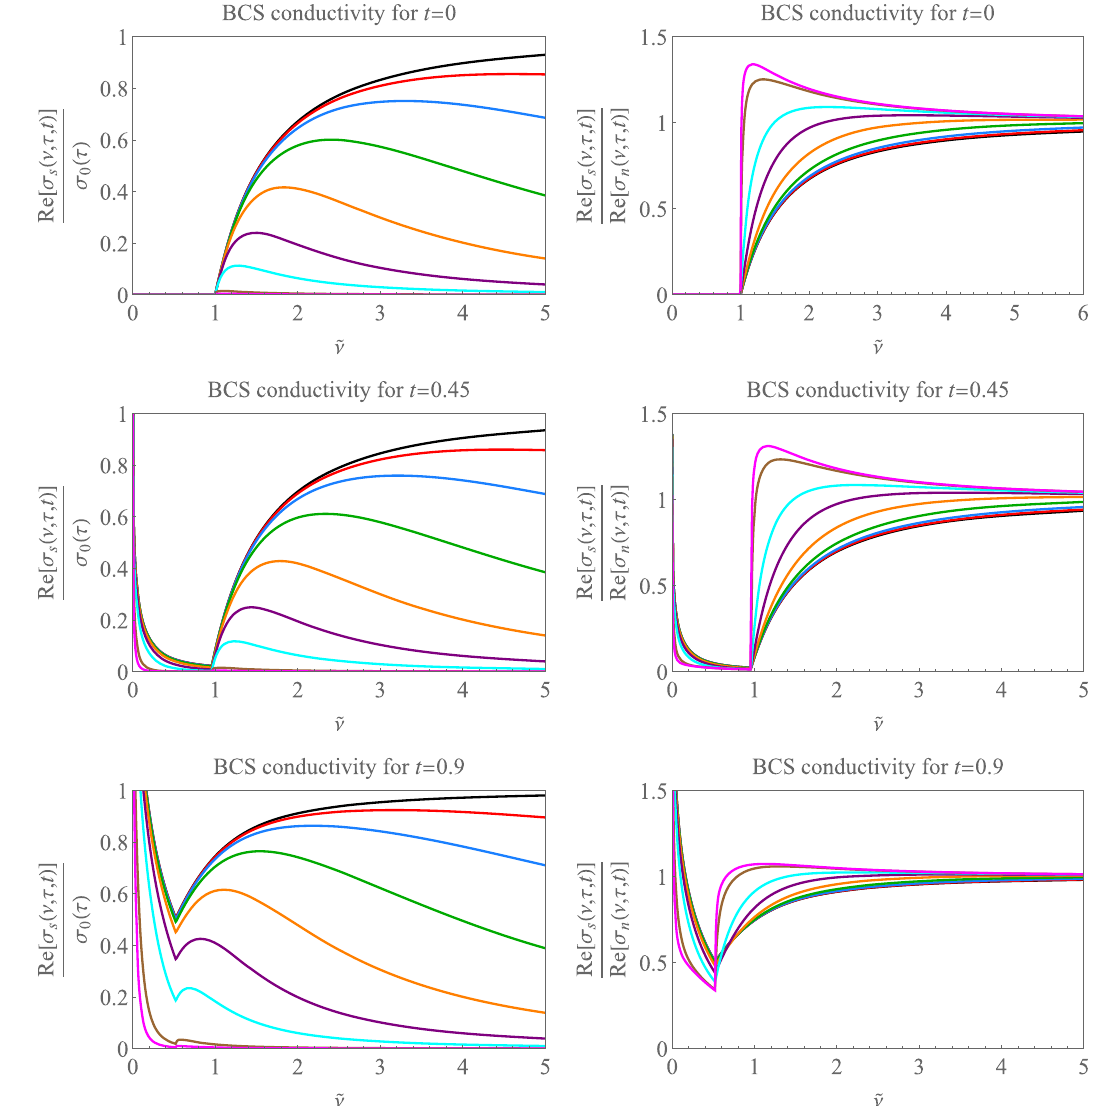
Fig. 5 Zero-temperature and fi nite reduced temperature plots ( t ≡ T / T c = 0.45 and t = 0.9) of the real part of the BCS electrical conductivity. Here we (cid:1) (cid:3) (cid:1) (cid:3) use units de fi ned by e ν (cid:3) ν = 2 Δ 0 and y ¼ 1 = 2 τ Δ 0 , where Δ 0 is the zero-temperature BCS gap. The y values (in order from the top curve (black) to the bottom curve (fuchsia) are given by y = 500 (dirty limit), 16, 8, 4, 2, 1, 1/2, 1/4, 1/8 (clean limit). In the fi gures on the left, we normalize by σ 0 ≡ ne 2 τ / m , whereas in the fi gures on the right we normalize by the normal-state results (which have Δ = ffiffiffiffiffiffiffiffiffiffiffiffiffiffiffiffi p 1 (cid:1) k 2 t 2 ffiffiffiffiffiffiffiffiffiffiffiffi p dt : ð 4 : 40 Þ 1 (cid:1) t 2